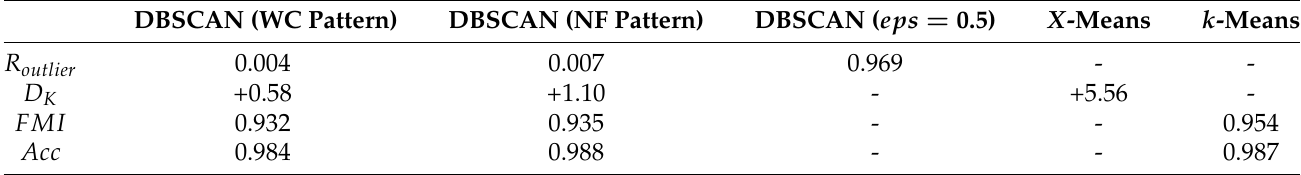
Figure 11. The values of (cid:99) eps (top figure) and their distribution (bottom table) in the NF pattern: (cid:99) eps candidates are 1.5, 2.0, 2.5, 3.0, 3.5, 4.0, 4.5, 5.0, 5.5, 6.0, 6.5, 7.0, and 7.5 in dataset A and B. (cid:99) eps candidates are 5.0, 5.5, 6.0, 6.5, 7.0, 7.5, 8.0, 8.5, 9.0, 9.5, 10.0, 10.5, 11.0, 11.5, 12.0, and 12.5 in dataset C. Table 3. Each evaluation parameter of DBSCAN (dataset